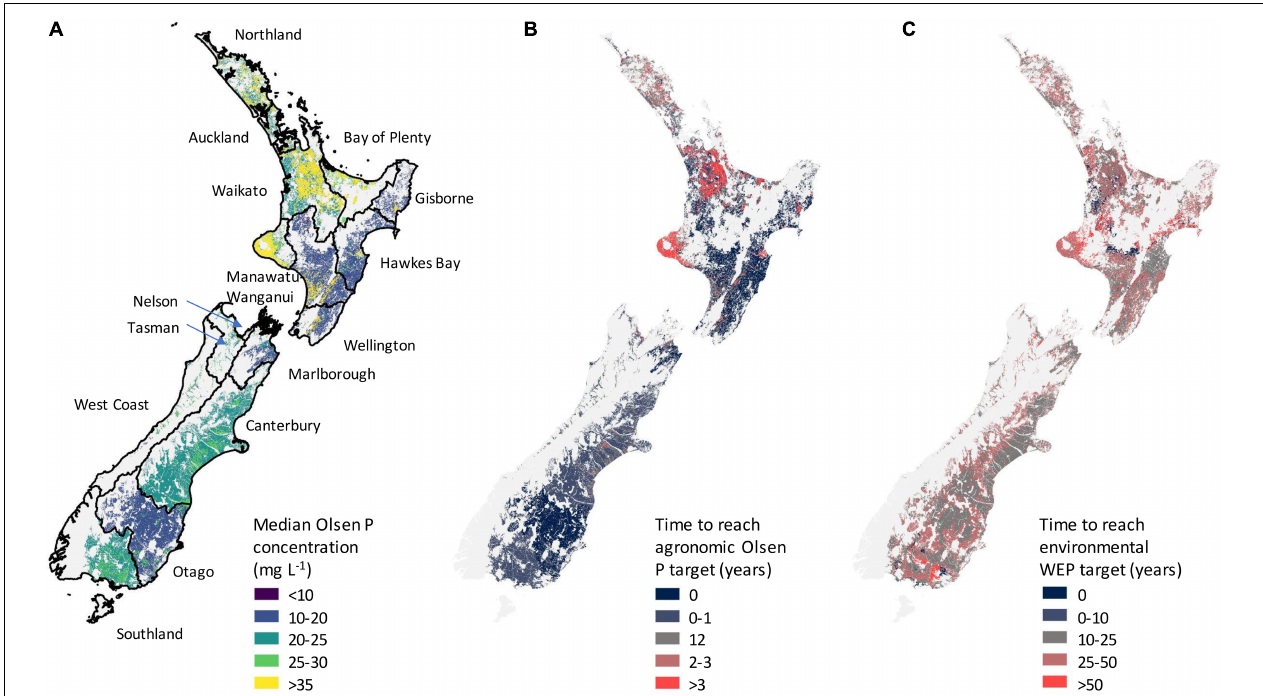
FIGURE 2 | Maps showing the distribution of median topsoil Olsen P (mg L − 1 ) concentrations (A) , and the number of years it would take areas to decrease their soil median soil Olsen P and water extractable P concentrations (mg L − 1 ) to agronomic (B) and environmental (C) targets,